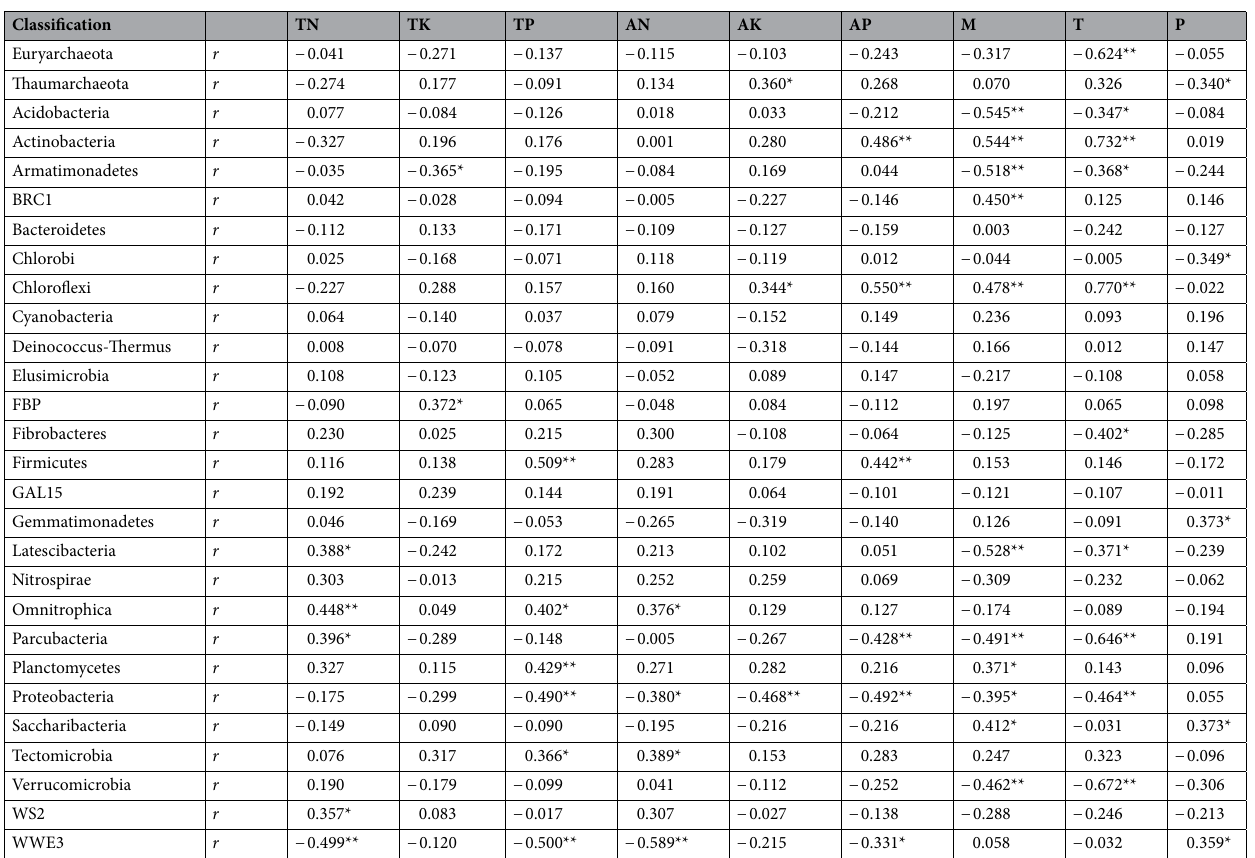
Table 2. Correlations between the measured environmental variables and relative abundances of rhizosphere prokaryotic phyla. The Spearman’s rank correlation coefficient ( r ) are shown. Correlations where p < 0.05